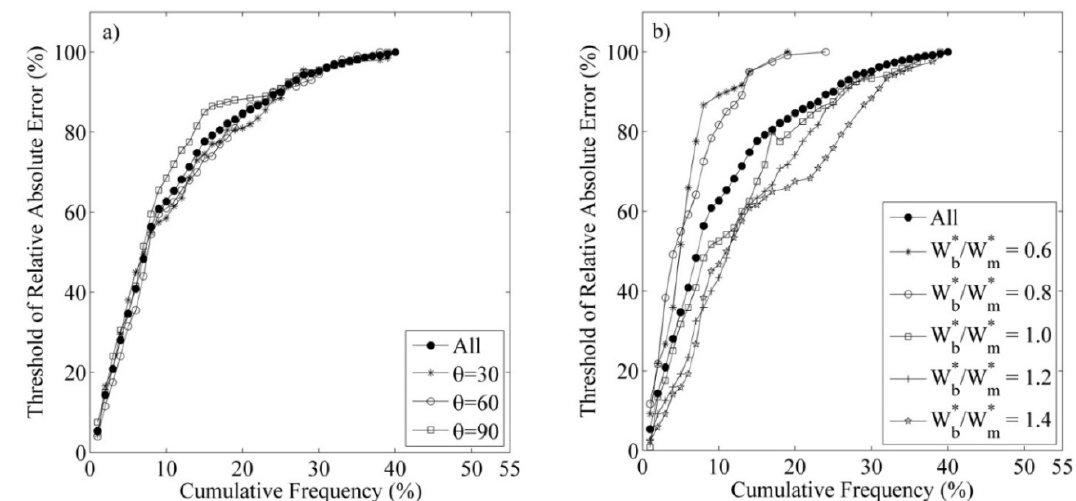
Figure 9. Error distribution of GMDH for ( a ) different angle ( θ ) ( b ) different relative width of branch channel to main channel (W b */W m *).